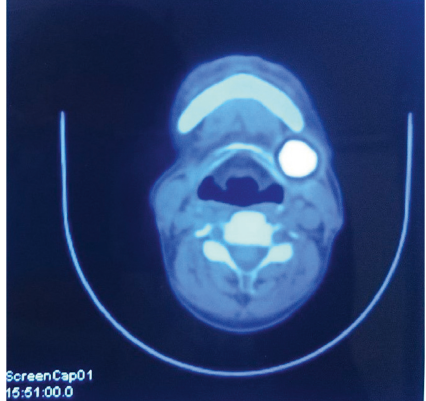
Figure 6: Positron emission tomography. 18 F-FDG PET-CT axial section shows hypermetabolic lesion involving the region of mandibular left third molar and level IB cervical lymph